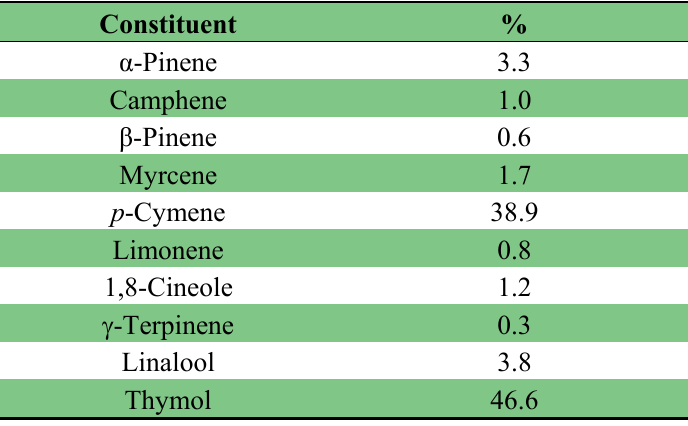
Table 4. Chemical composition of T. vulgaris essential